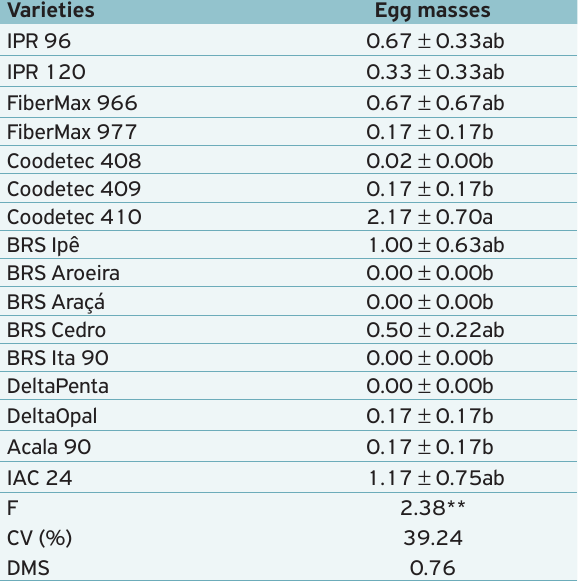
Table 3. Numbers (mean ± standard deviation) of Spodoptera frugiperda egg masses on different cotton varieties, 72 h after infestation, in a free-choice test.